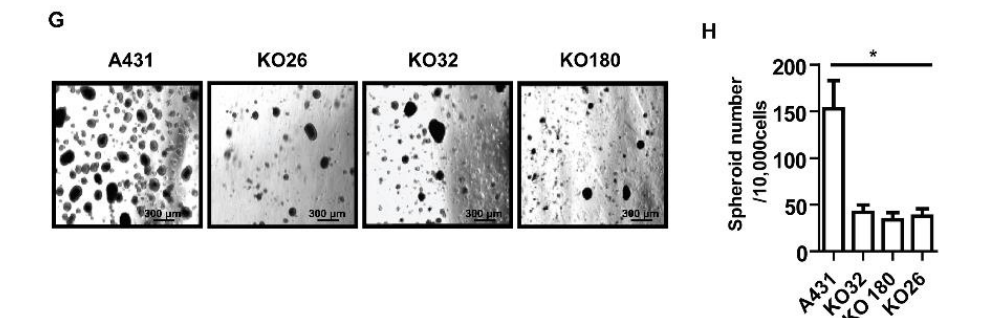
Figure 3. CD109 is required for maintaining the stemness of SCC cells, and the loss of CD109 diminishes cancer stem cell population in vitro in SCC cells. ( A ): Western blot analysis of OCT4, Sox2, and Nanog in control A431 versus CD109 KO A431, and control FaDu versus CD109-KD FaDu cells. ( B , C ): Representative images of Flow cytometry for CD109 ( B ) and CD44 ( C ), showing CD44 expression markedly diminished in CD109 KO cells. ( D – F ): Fluorescent microscopy of control A431 versus CD109 KO A431cells, and control FaDu versus CD109 KD cells: ( D ) Anti-Sox2 (red) and anti-CD109 (green); ( E ) Anti-Oct4 (red) and Anti-CD109 (green); ( F ) Anti-Nanog (red) and Anti-CD109 (green). ( G ): Representative phase-contrast images of spheroid formation assay with indicated cells. ( H ): Quantification of the number of tumor spheroids. All the results were expressed as the mean ± S.D. of three independent experiments. Significance was calculated using a One-Way ANOVA * p < 0.001. Uncropped WB images were shown in Figure